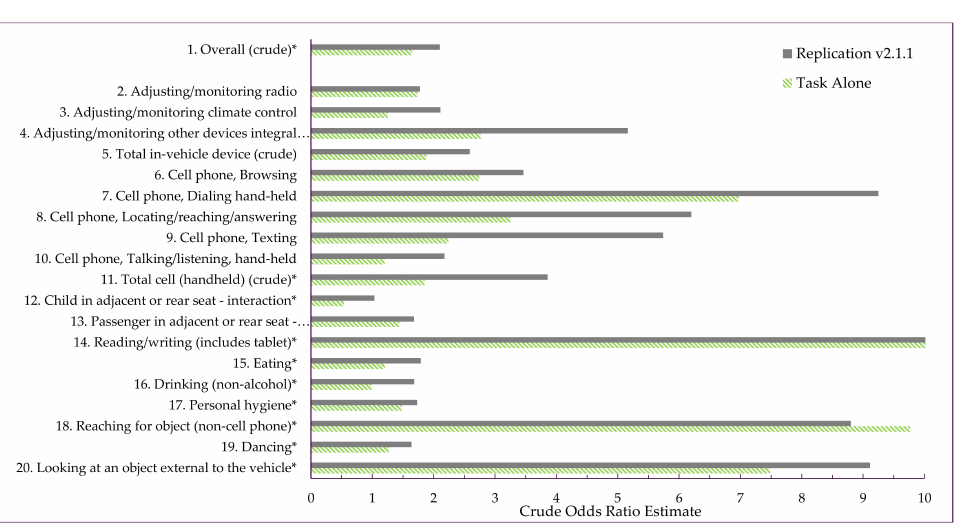
Figure A2. Solid gray bars : Replicated Dingus study secondary task category OR point estimates from Appendix B Table A2B. Diagonally-hatched green bars : Current “Task Alone” OR point estimates